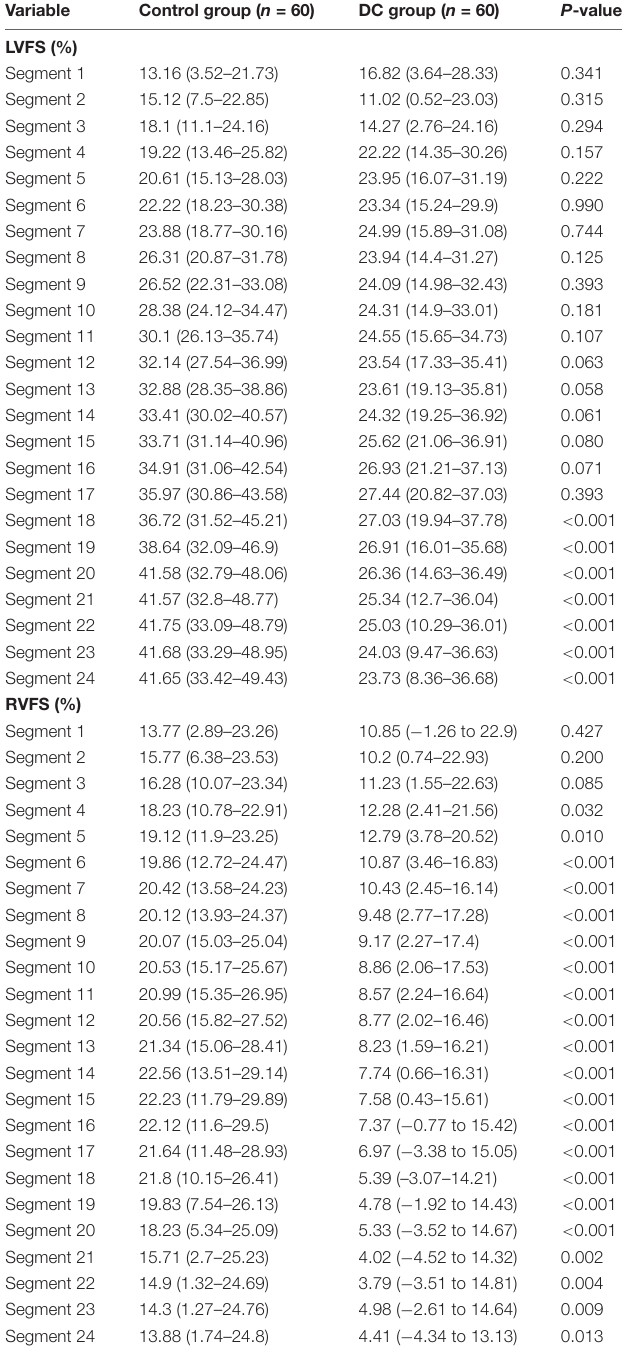
TABLE 4 | Biventricles 24-segments FS in the DC group and the control